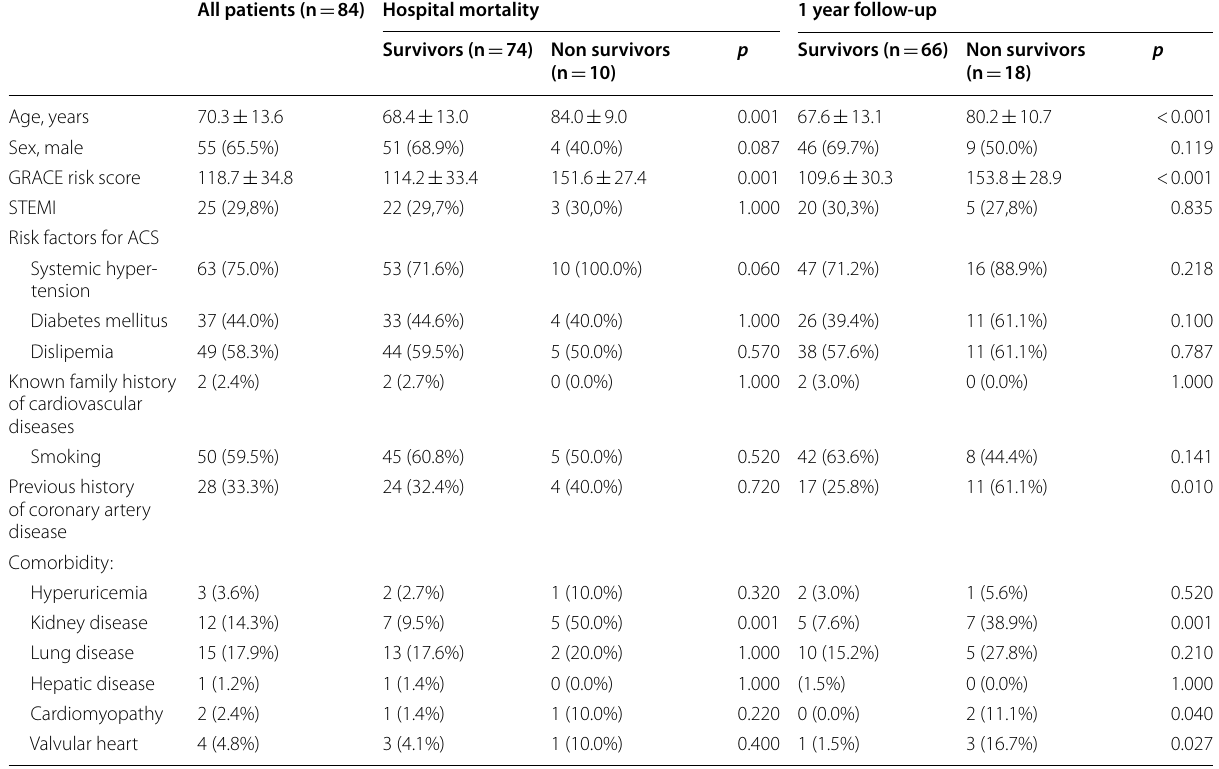
Table 1 Characteristics of study